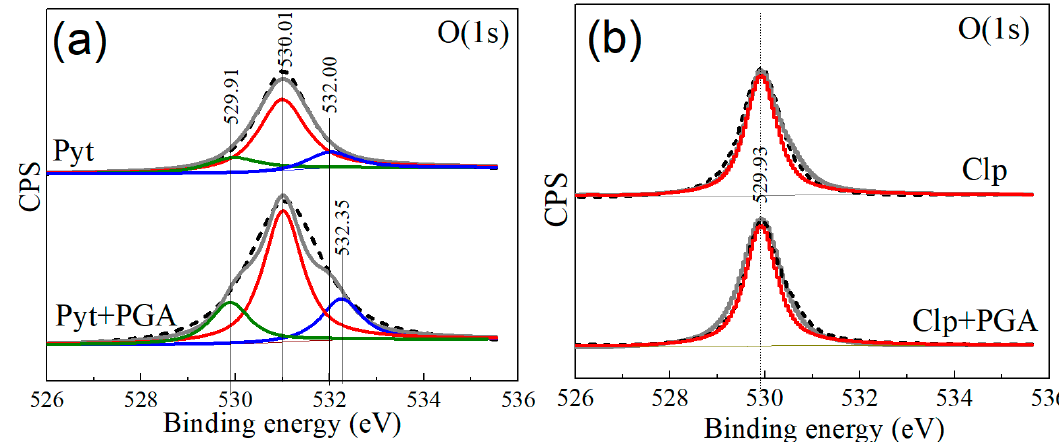
Figure 10. High-resolution XPS spectra of O(1s) species from surfaces of ( a ) pyrrhotite (Pyt) and ( b ) chalcopyrite (Clp) before and after the reaction with 50 mg/L PGA at pH 8.